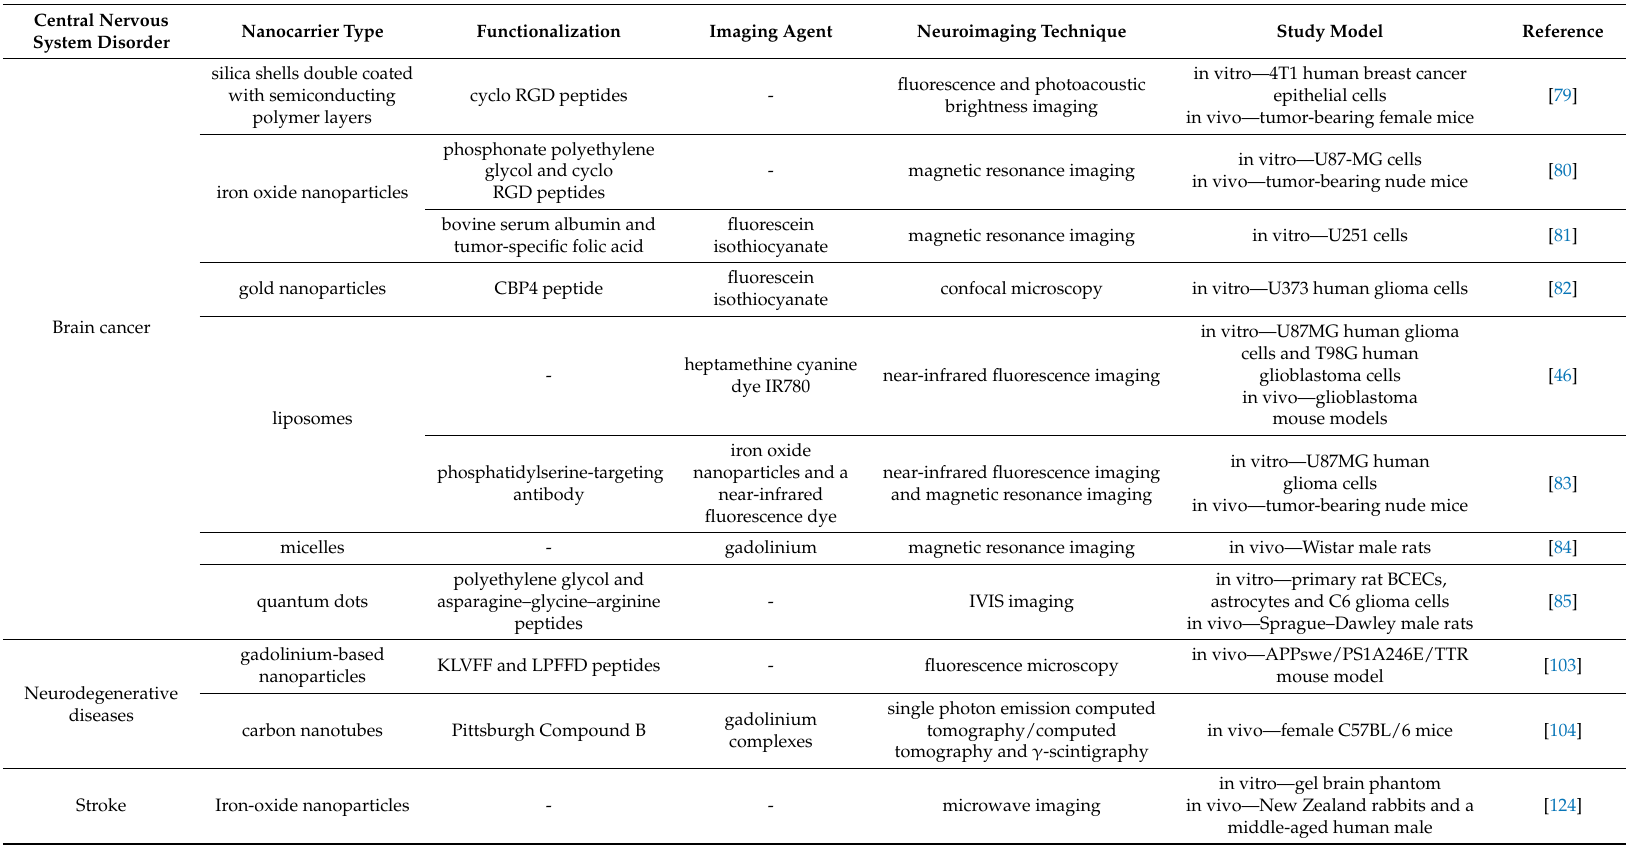
Table 2. A summary of the nanotechnology-based neuroimaging approaches for the diagnosis of brain cancer, neurodegenerative diseases, and stroke. Central Nervous System